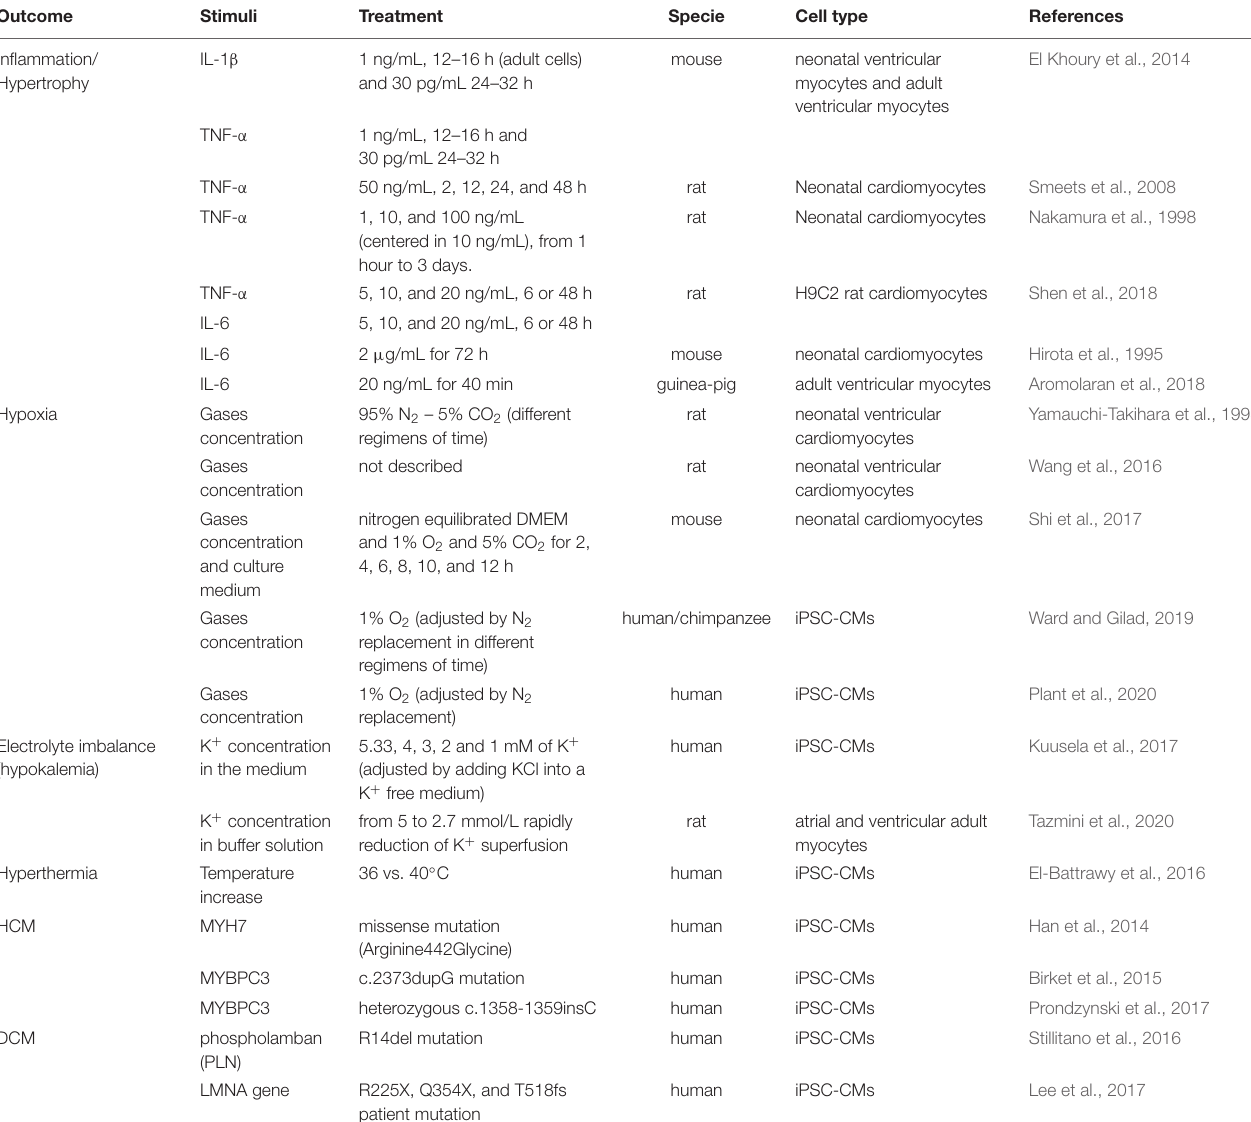
TABLE 1 | In vitro models to be used to mimic “COVID-19